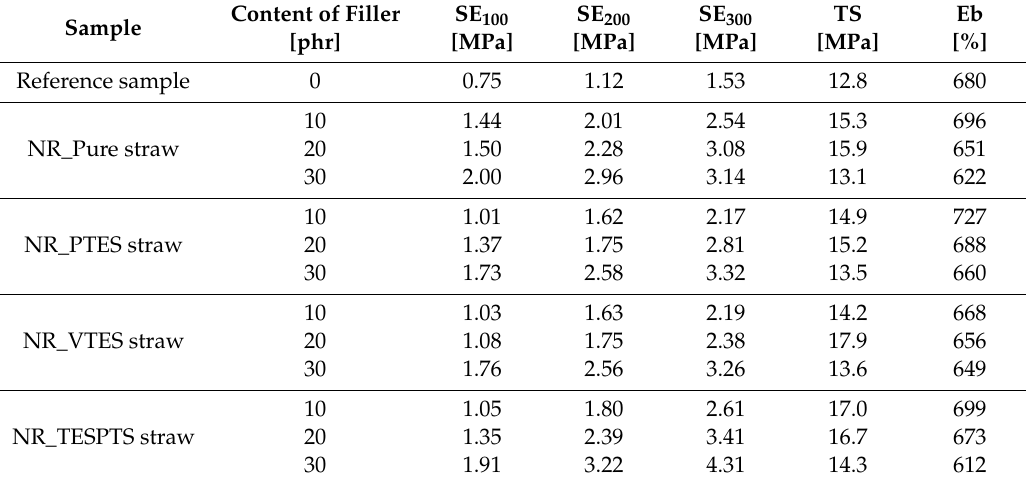
Table 4. Mechanical properties of NR